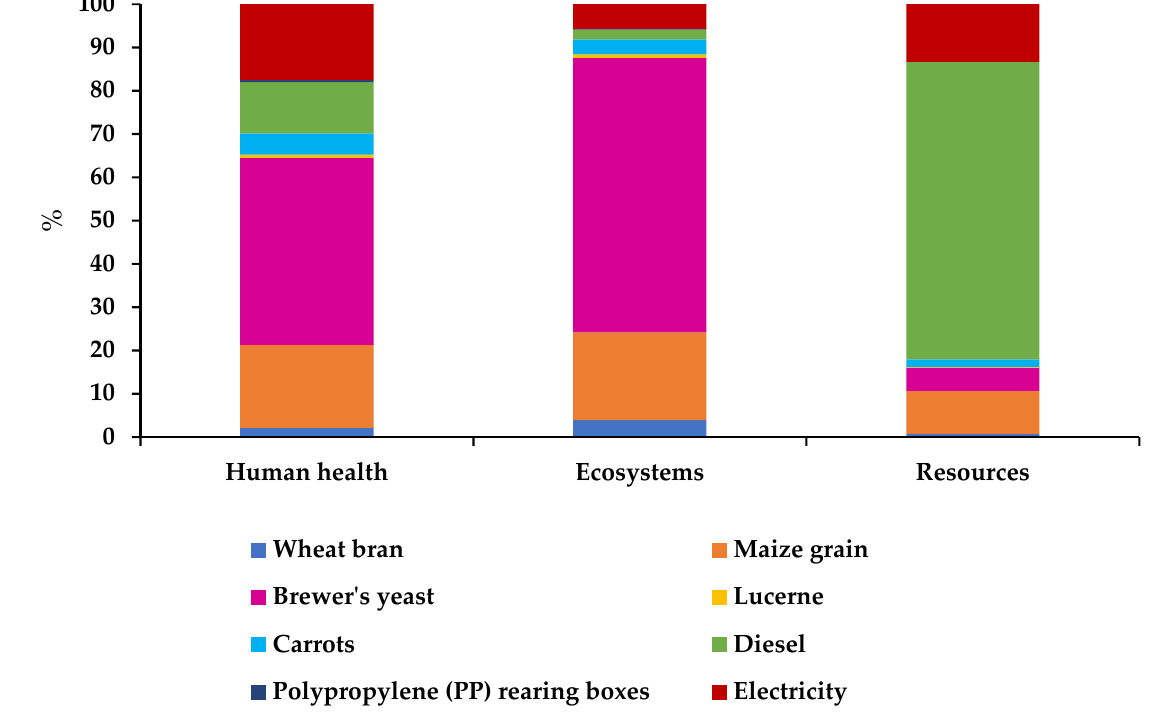
Figure 3 . Characterized results for mealworm production divided into the three macro-categories . Figure 3. Characterized results for mealworm production divided into the three